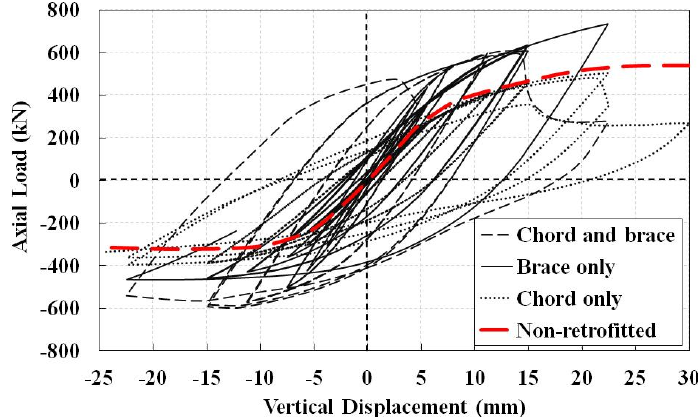
Figure 10. Hysteresis diagrams for different retrofitting schemes of the J1 model. Eight FRP layers with symmetric distribution of (0/90)2s.